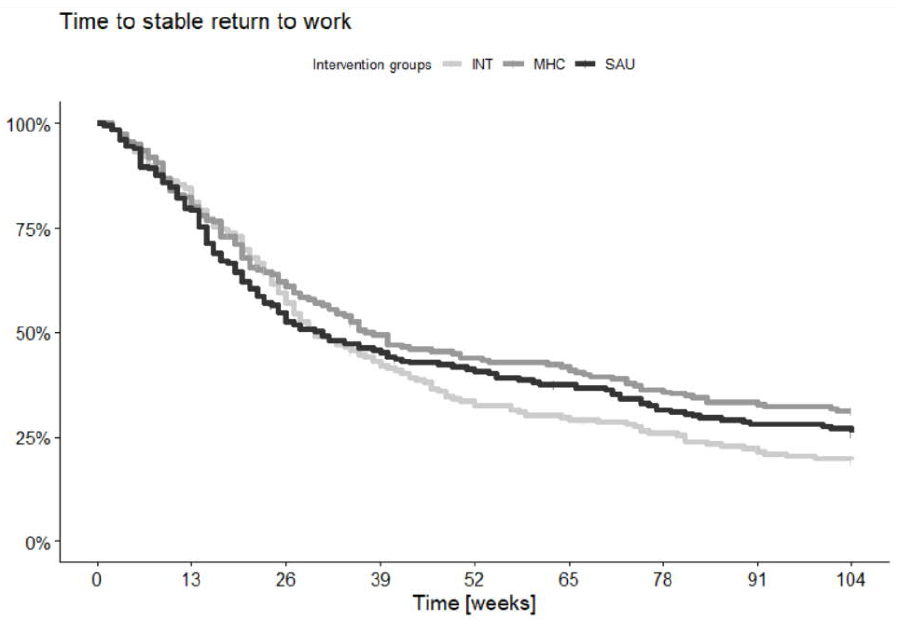
Figure 2. Kaplan-Meier curve for time to the event ‘first stable return to work’. [INT=IBBIS integrated intervention; MHC=mental healthcare; SAU=service as